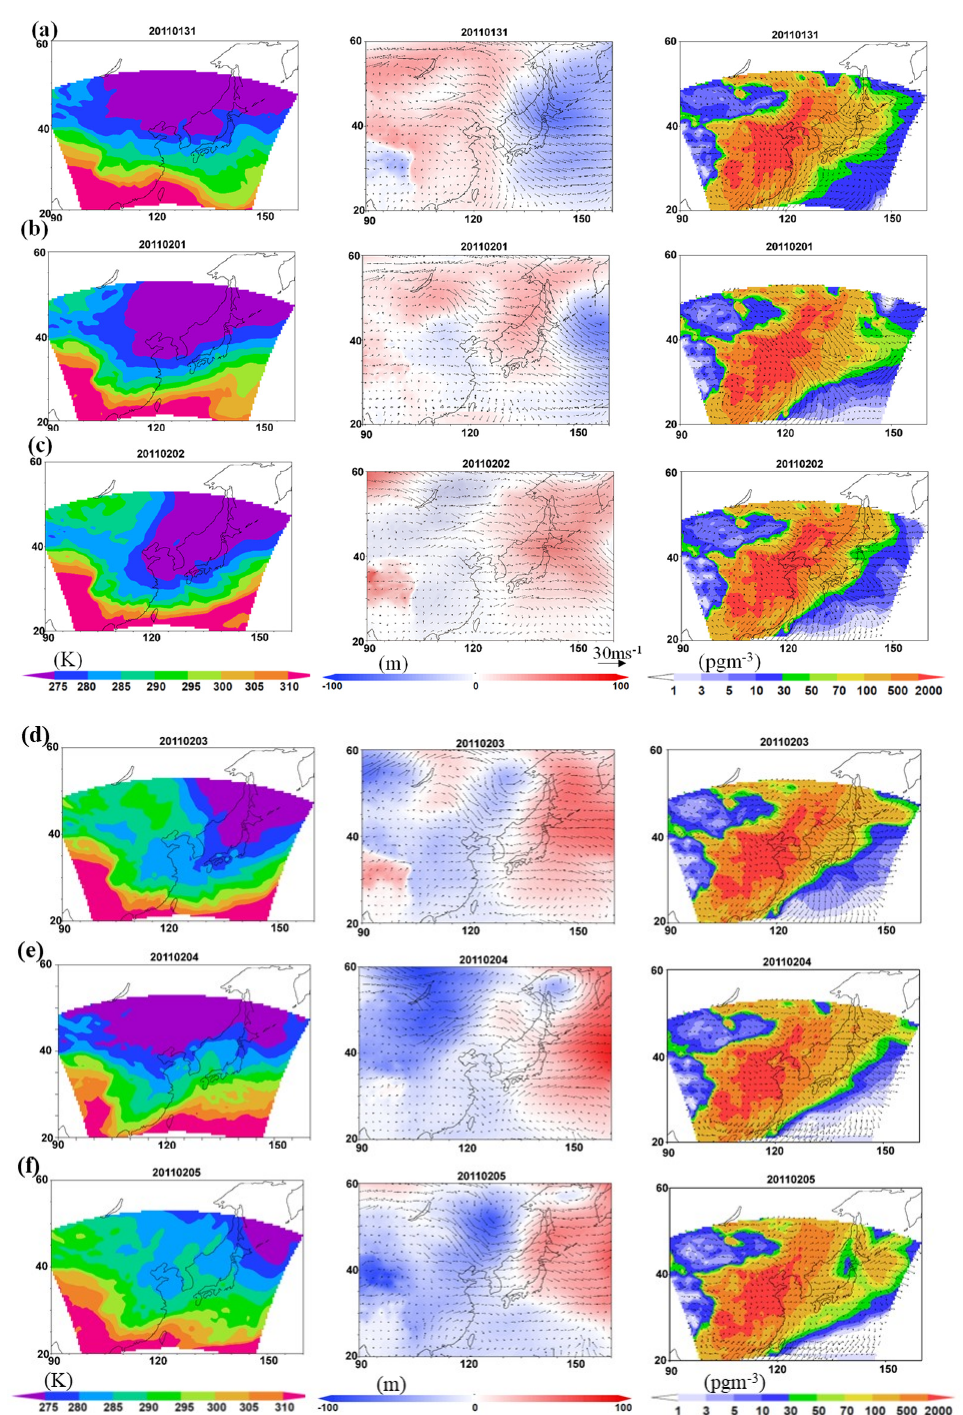
Figure 8. Horizontal distributions of ePT (850 hPa), geopotential height anomaly (850 hPa), and p-AH concentration in Northeast Asia from 31 January to 5 February 2011. ( a ) 31 January 2011, ( b ) 1 February 2011, ( c ) 2 February 2011, ( d ) 3 February 2011, ( e ) 4 February 2011, and ( f ) 5 February 2011. An air mass with a low ePT occurred over the Japanese Islands from 31 January to 2 February 2011, and the observed low ePT areas shifted northward after 3 February 2011 during this analysis period. In the later period, the geopotential height anomaly during the analytical period (31 January to 5 February 2011) was relatively low over the Japanese Islands. Under the colder air mass conditions, p-PAH concentration gradually increased